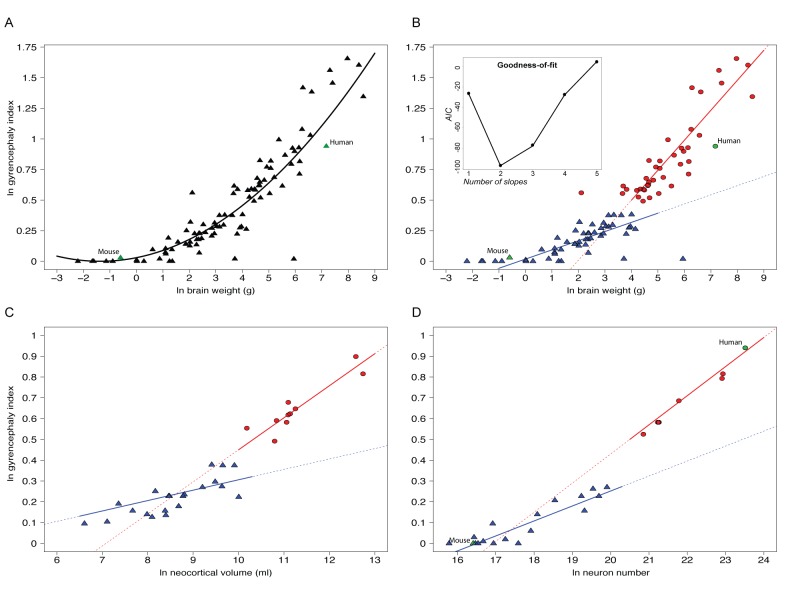
Ln-transformed plots showing GI values as a function of adult brain weight (A, B), neocortical volume (C), and cortical neuron number (D).(A) Regression analysis using one non-linear fit for all values (101 species [see Table S1, with C. volans being omitted from this analysis], y = 0.018x
2+0.037x+0.014, R2 = 0.612, p = 6×10−5); (B–D) regression analyses using two different linear functions (B, 101 species, blue line: y = 0.075x−0.481, R2 = 0.56, p = 4×10−5, red line: y = 0.245x+0.018, R2 = 0.73, p = 1×10−5; (C), 32 species (see Table S1, column E), blue line: y = 0.050x−0.194, R2 = 0.21, p = 0.017, red line: y = 0.154x−1.09, R2 = 0.82, p = 0.004; (D), 25 species (see Table S8), blue line: y = 0.072x−1.188, R2 = 0.81, p = 1×10−4; red line: y = 0.140x−2.370, R2 = 0.98, p = 3×10−5) for species with GI values of <1.5 (blue triangles) and >1.5 (red circles), respectively; mouse and human (when depicted) are indicated by green symbols. The inset in (B) shows the Akaike Information Criterion (AIC) values for models fitted with one to five linear slopes; note that a two-slope model best explains the data.